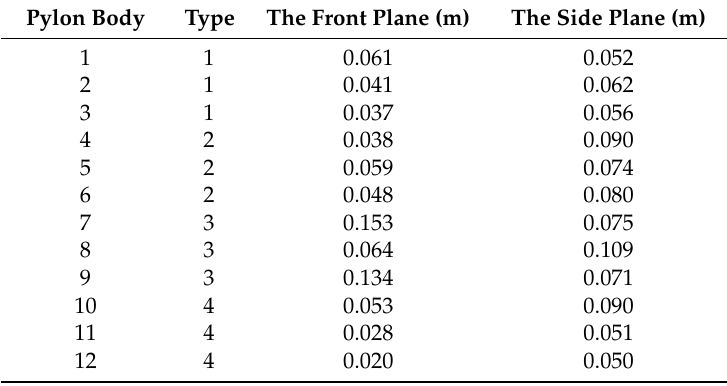
Table 5. The related accuracy of pylon body reconstruction.